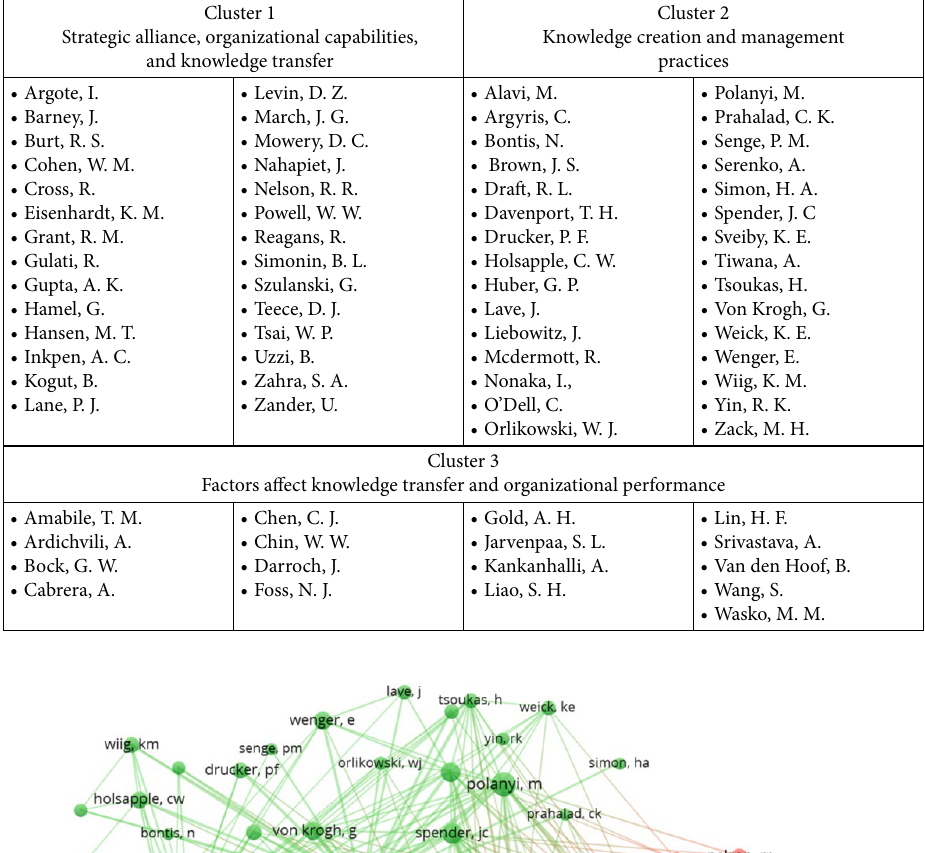
Table 8. Clustering resulting for the most cited authors